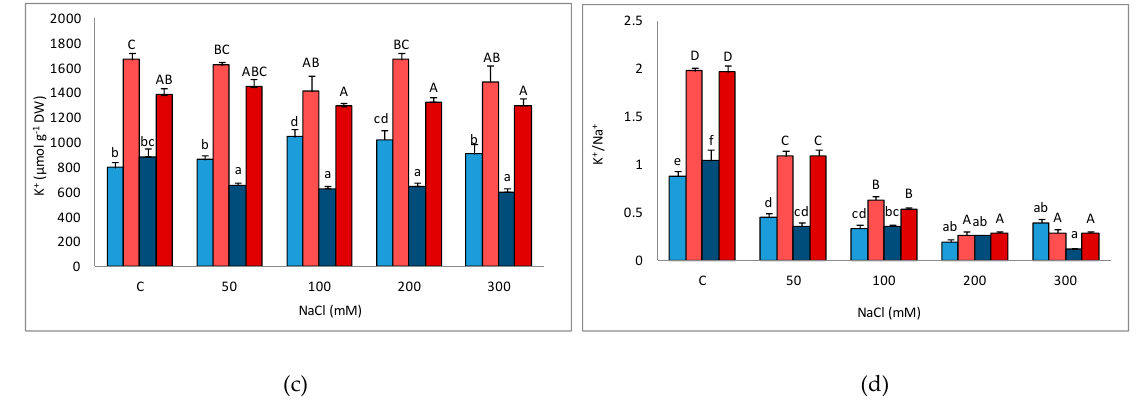
Figure 3. Na + ( a ), Cl − ( b ), and K + ( c ) contents and K + / Na + ratio ( d ) in roots (MELr and INSr) and leaves (MELl and INSl) in Solanum melongena (blue) and S. insanum (red), after 25 days of treatments with the indicated NaCl concentrations. Mean ± SE values are shown ( n = 5). Same letters (lowercase for roots, or uppercase for leaves) indicate homogeneous groups between combinations of treatments, according to the Tukey HSD test ( p < 0.05).